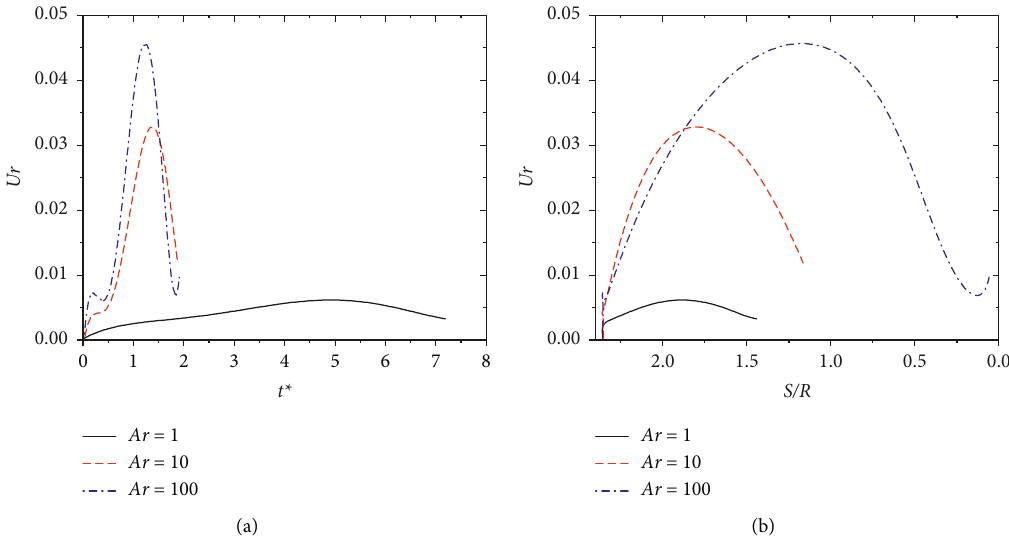
Figure 10: The effect of Ar on the instantaneous relative velocity at Bo � 50. (a) Relative velocity versus time; (b) relative velocity versus bubble center distance.